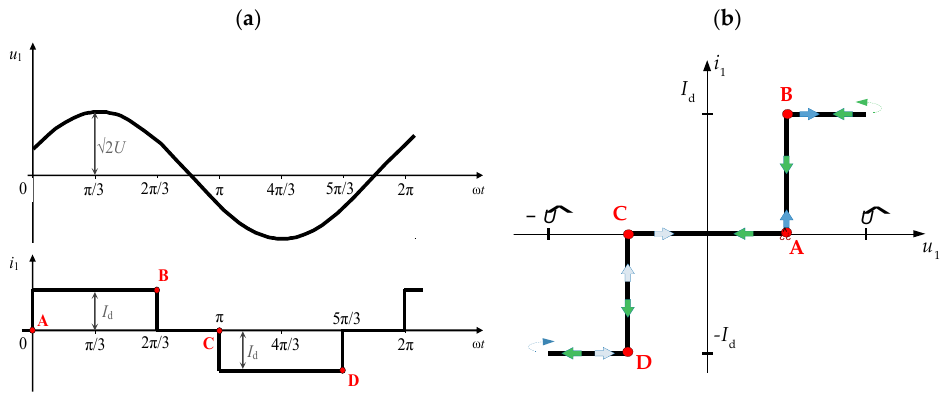
Figure 3. Typical voltage and current waveforms ( a ) and corresponding u – i characteristic ( b ) of an uncontrolled rectifier of phase 1.